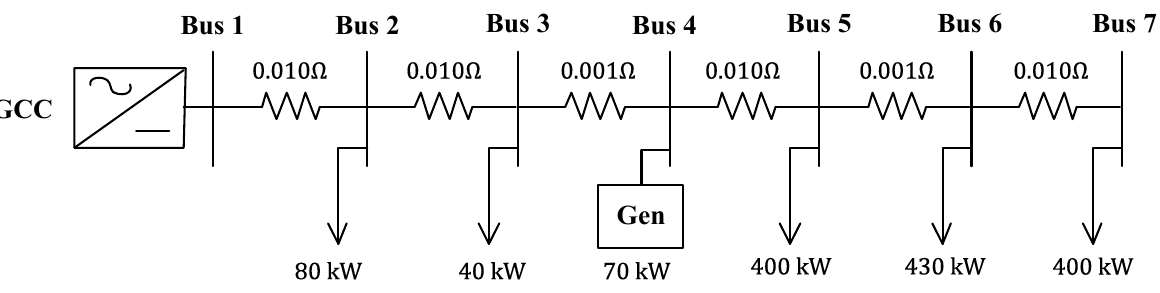
Figure 4. A test radial system for the optimal allocation algorithm in